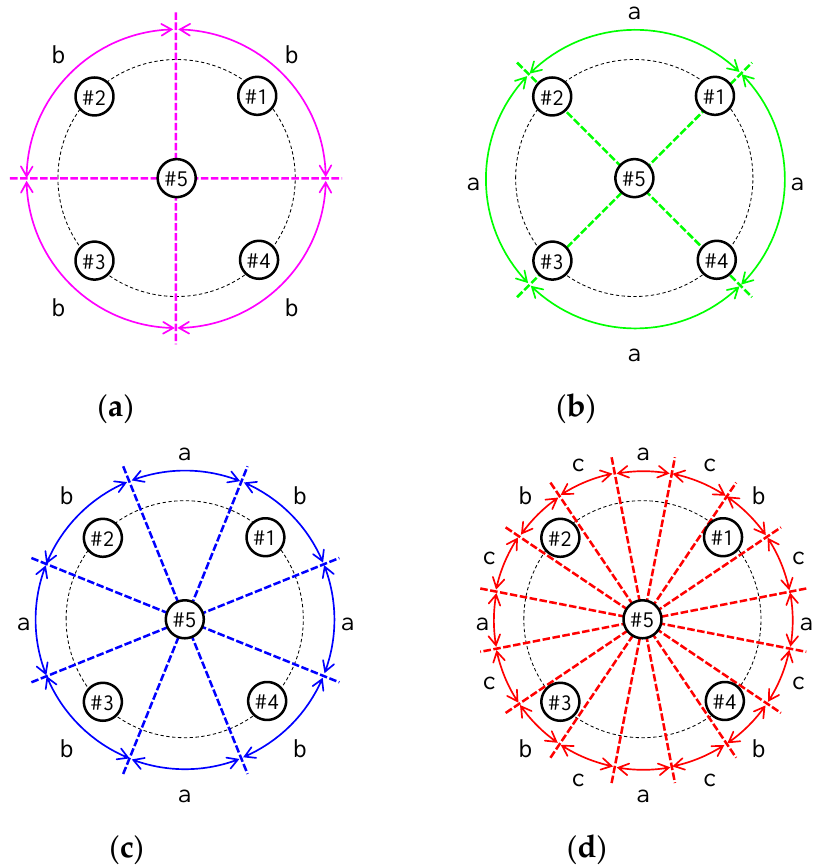
Figure 18. Division patterns of the beamforming area: ( a ) 90° intervals from 0°; ( b ) 90° intervals from 45°; ( c ) 45° intervals; and ( d ) 22.5° intervals.